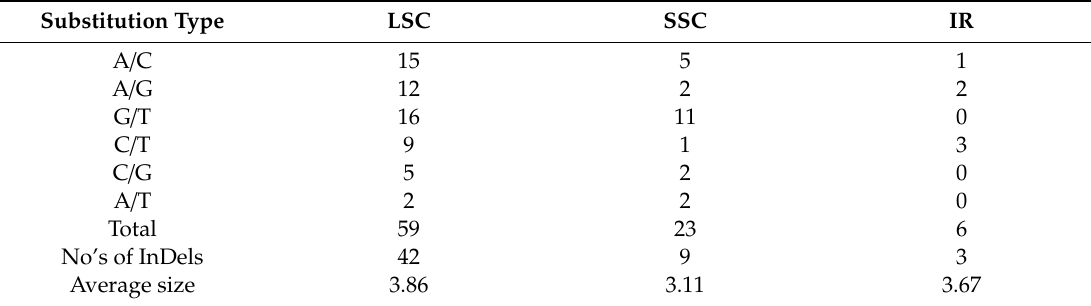
Table 4. Substitutions and InDels events in the chloroplast genome of Artemisia scoparia